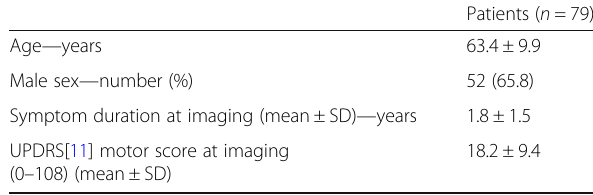
Table 1 Demographic and clinical